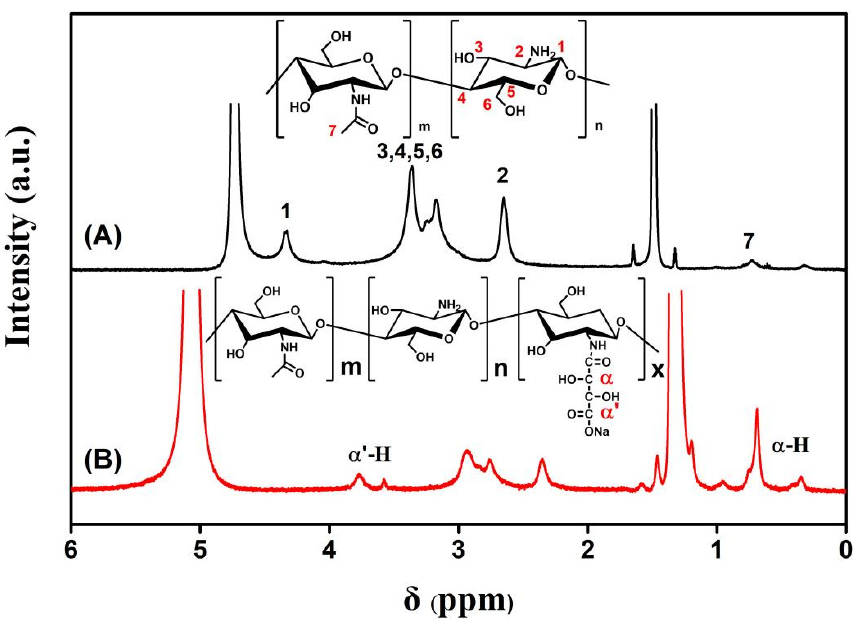
Figure 2. 1 H-NMR (nuclear magnetic resonance) spectra of ( A ) chitosan and ( B ) CS-TA-Na in CD 2 COOD/D 2 O = 2:98 ( w 1: w 2 ) solvent.